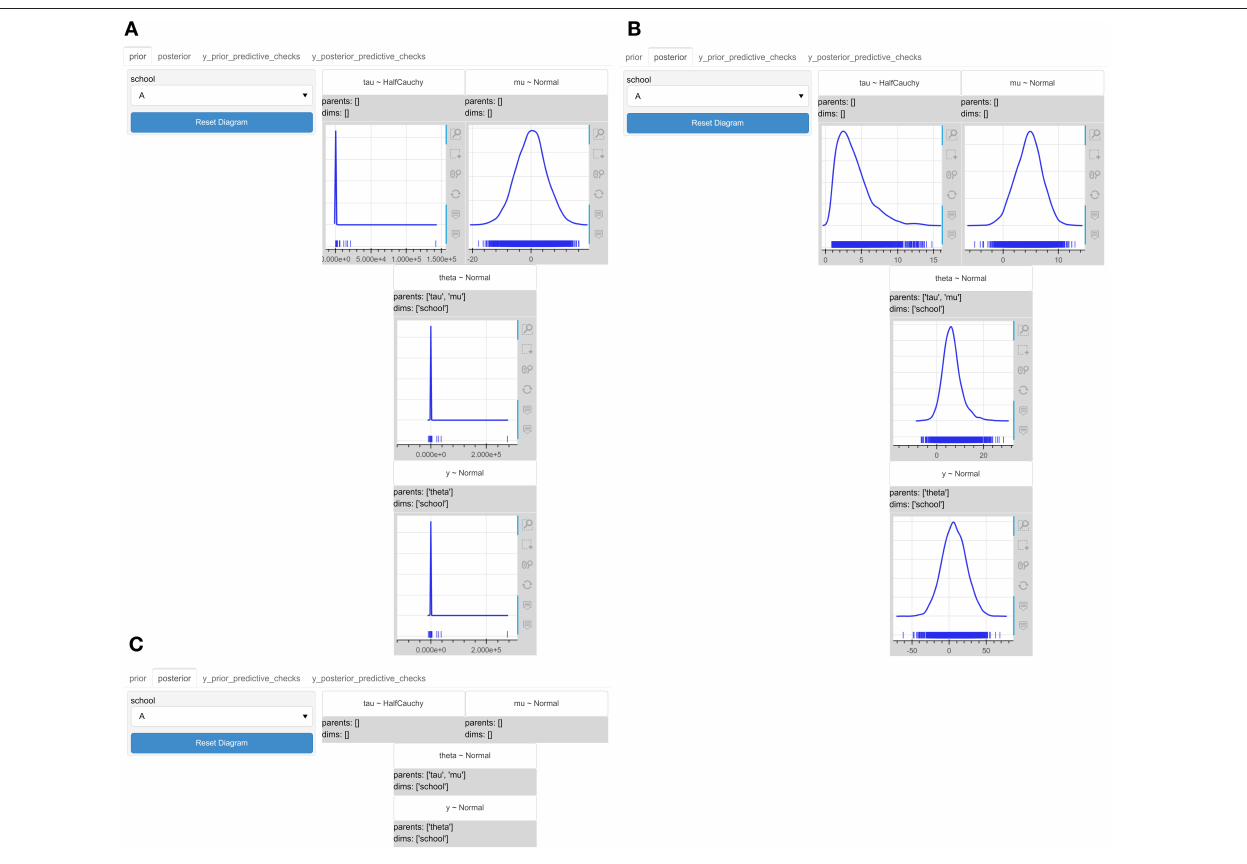
FIGURE 4 | The interactive probabilistic models explorer of the centered hierarchical model of the eight schools problem. PyMC3 was used for the model’s specification and inference. (A) The prior graphical representation. (B) The posterior graphical representation. (C) The collapsed graphical representation. The interactive probabilistic models explorer integrates the simulated inference data and provides variable granularity in the amount of the presented